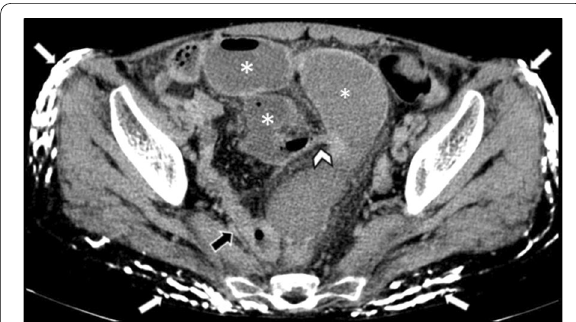
Fig. 20 Small bowel obstruction in a 31-year-old female with known scleroderma presenting with generalized abdominal pain, nausea, and vomiting without previous Hx of surgery. Axial view of CTE shows extensive cutaneous and subcutaneous calcifications (thick white arrows). Short segment benign-looking stricture (white arrowhead) is seen at the distal ileum in the pelvis, leading to upstream small bowel dilatation (white asterisks). Following segmental resection and anastomosis, this was confirmed to be a fibrotic stricture. Collapsed ileum distal to stricture is also depicted (thick black arrow)